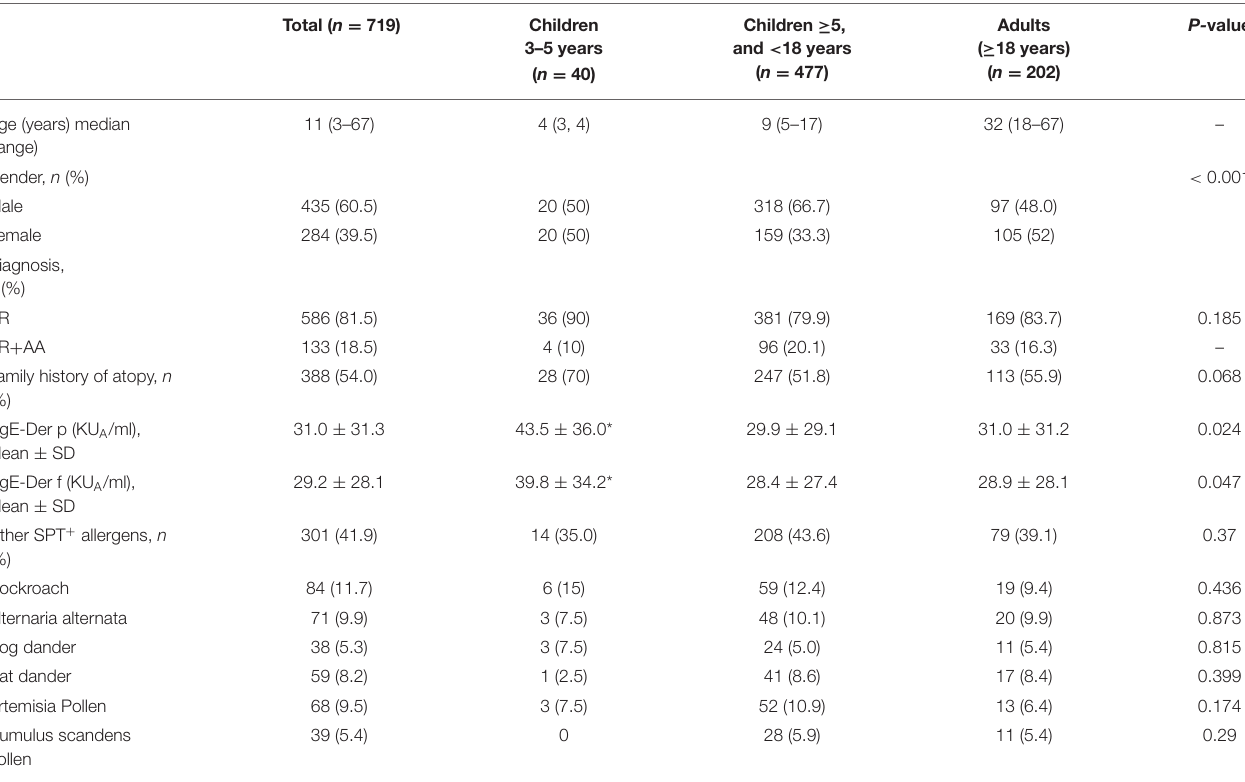
TABLE 1 | Demographic characteristics and clinical signs at